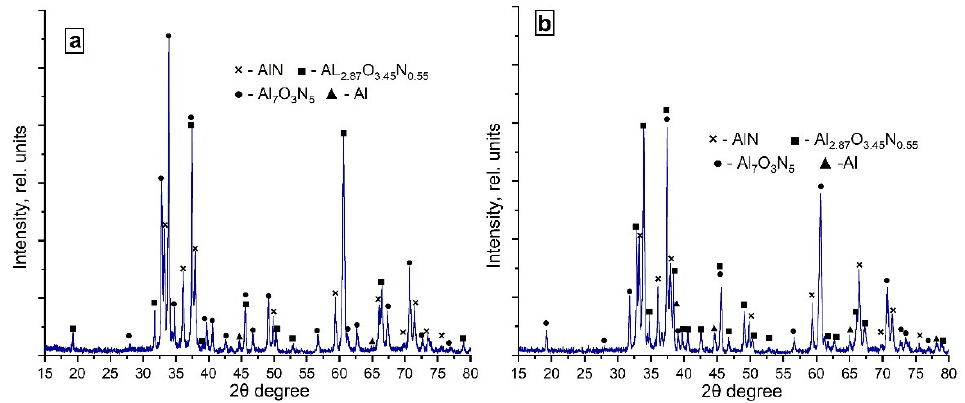
Figure 10. XRD patterns of the combustion products obtained from the (70% AlN+ 30% Al) sample in the nitrogen–argon flow: ( a ) Ar = 15%, q = 3.0 cm 3 /(s∙cm 2 ) and ( b ) Ar = 15%, q = 5.0 cm 3 /(s∙cm 2 ).